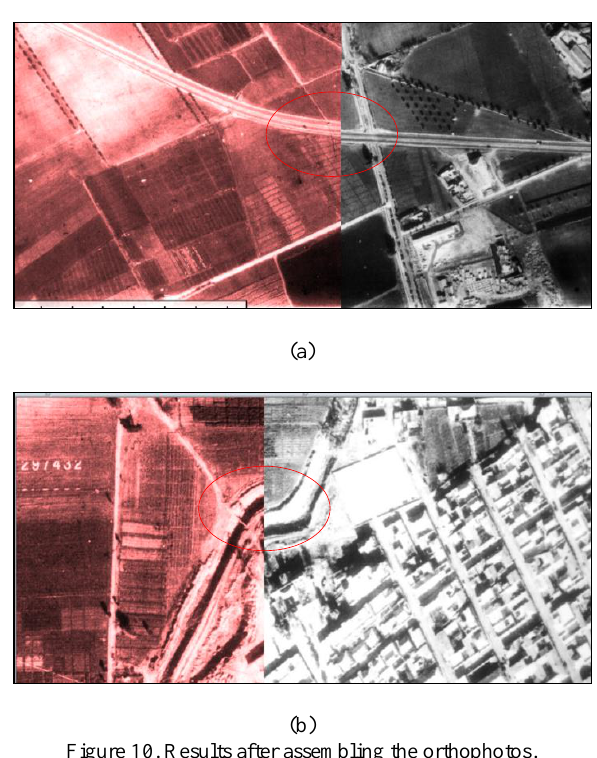
Figure 11. Distribution of reference control points and tie points According to the test that we carried out on all orthoimages, we accuracy on tie points image coordinates equals to 1.285 pixel and 0.969 pixel in x and y directions respectively.